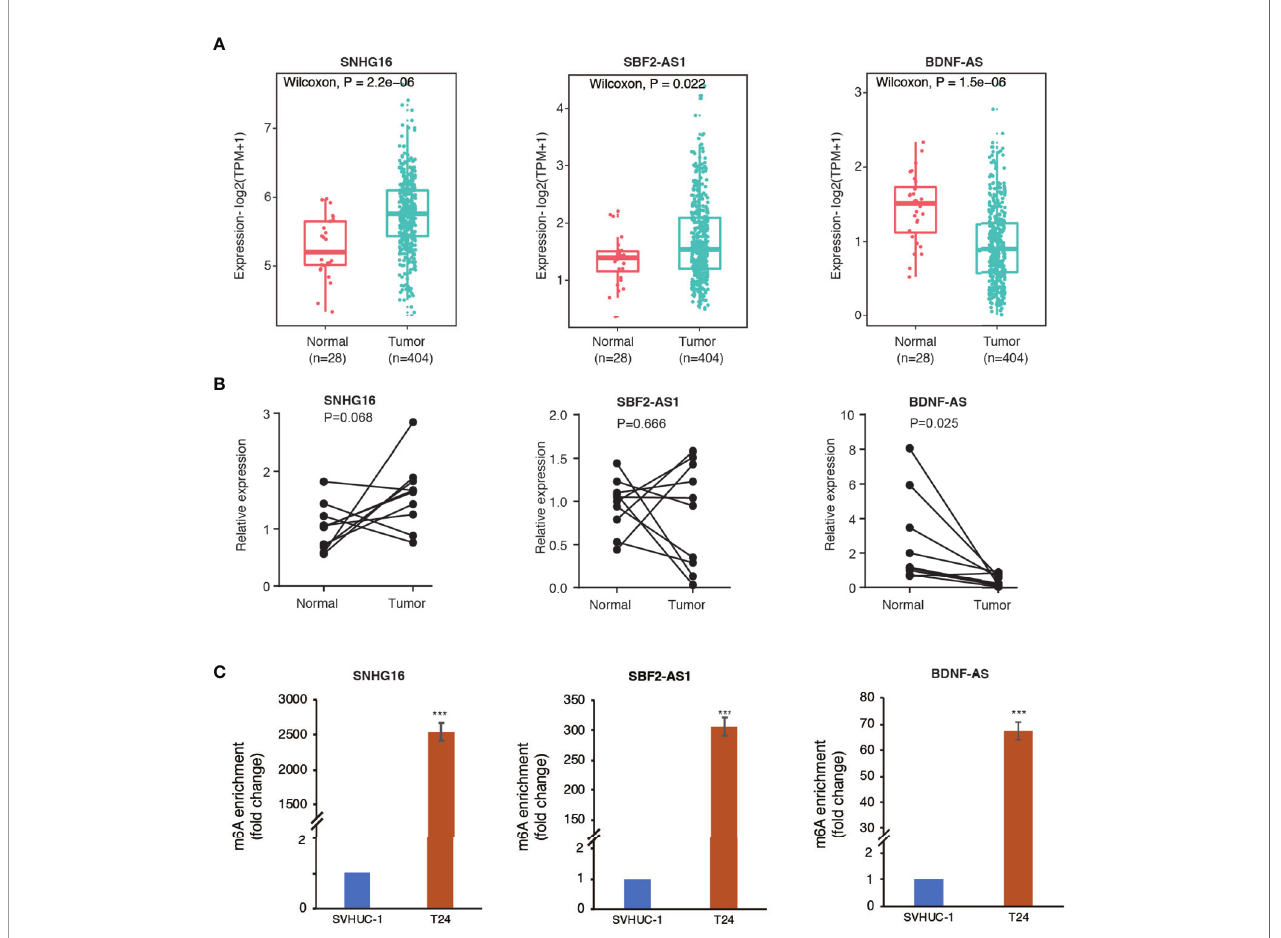
FIGURE 8 | Methylated RNA immunoprecipitation (MeRIP) con fi rmed m6A enrichment in three selected lncRNAs. (A) The differential expression of SNHG16, SBF2-AS1, and BDNF-AS in bladder cancer samples compared to adjacent normal controls in TCGA and GTEx RNA-seq data. (B) The expression levels of the three lncRNAs in ten pairs of clinical samples. (C) The bar plots indicate relative m6A enrichment in T24 cells in comparison to SVHUC1 cells by MeRIP-qPCR assay. ***P <